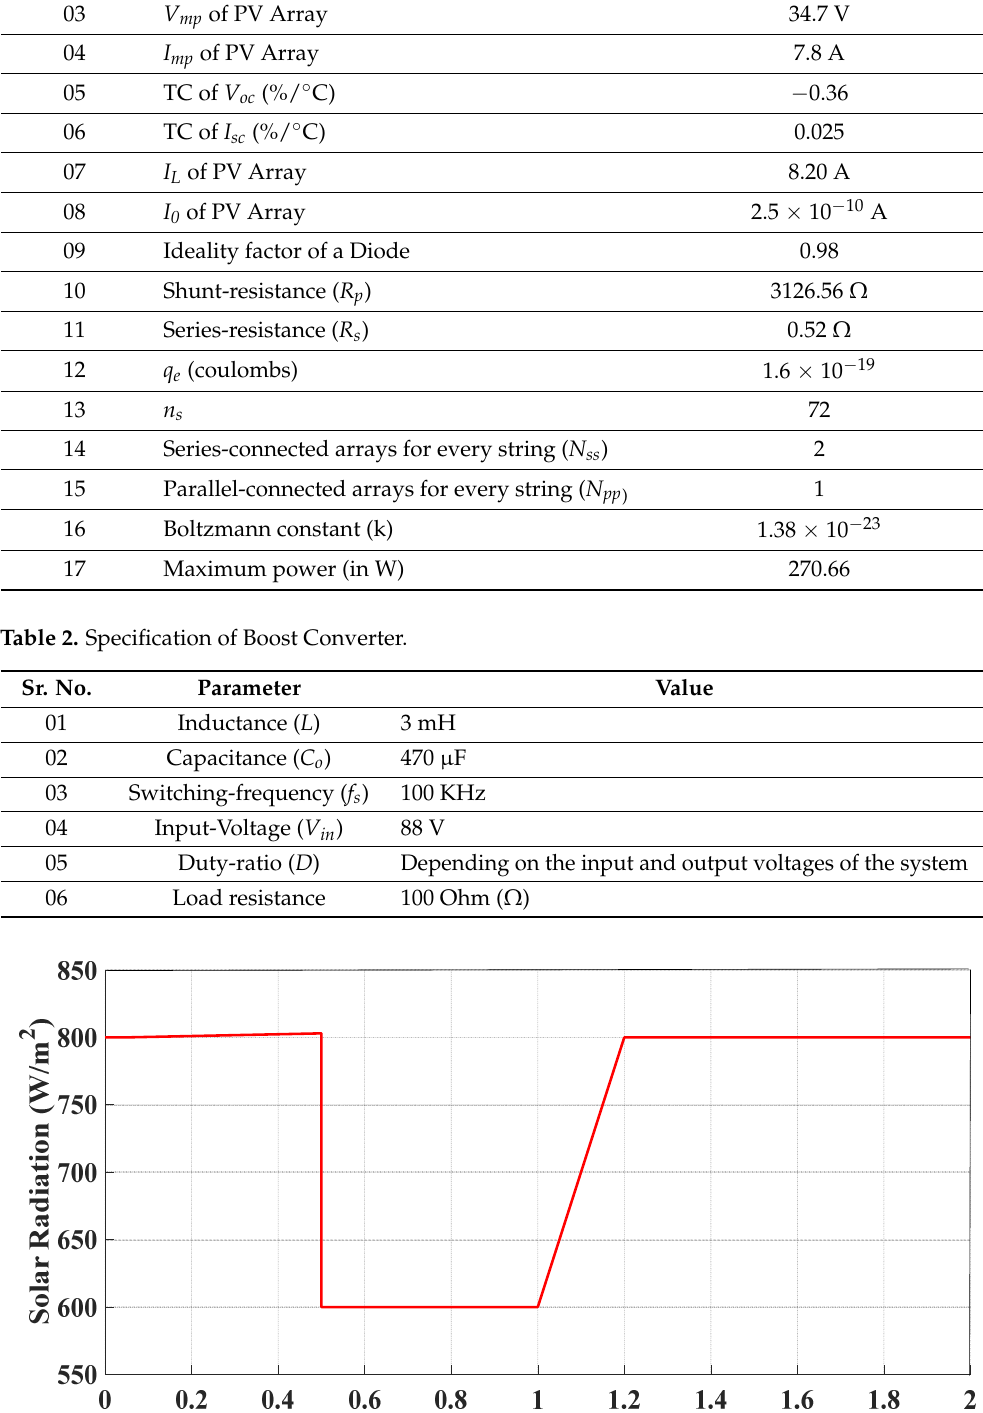
Figure 2. SR Test Pattern (in W/m 2 ) for Simulation Analysis.